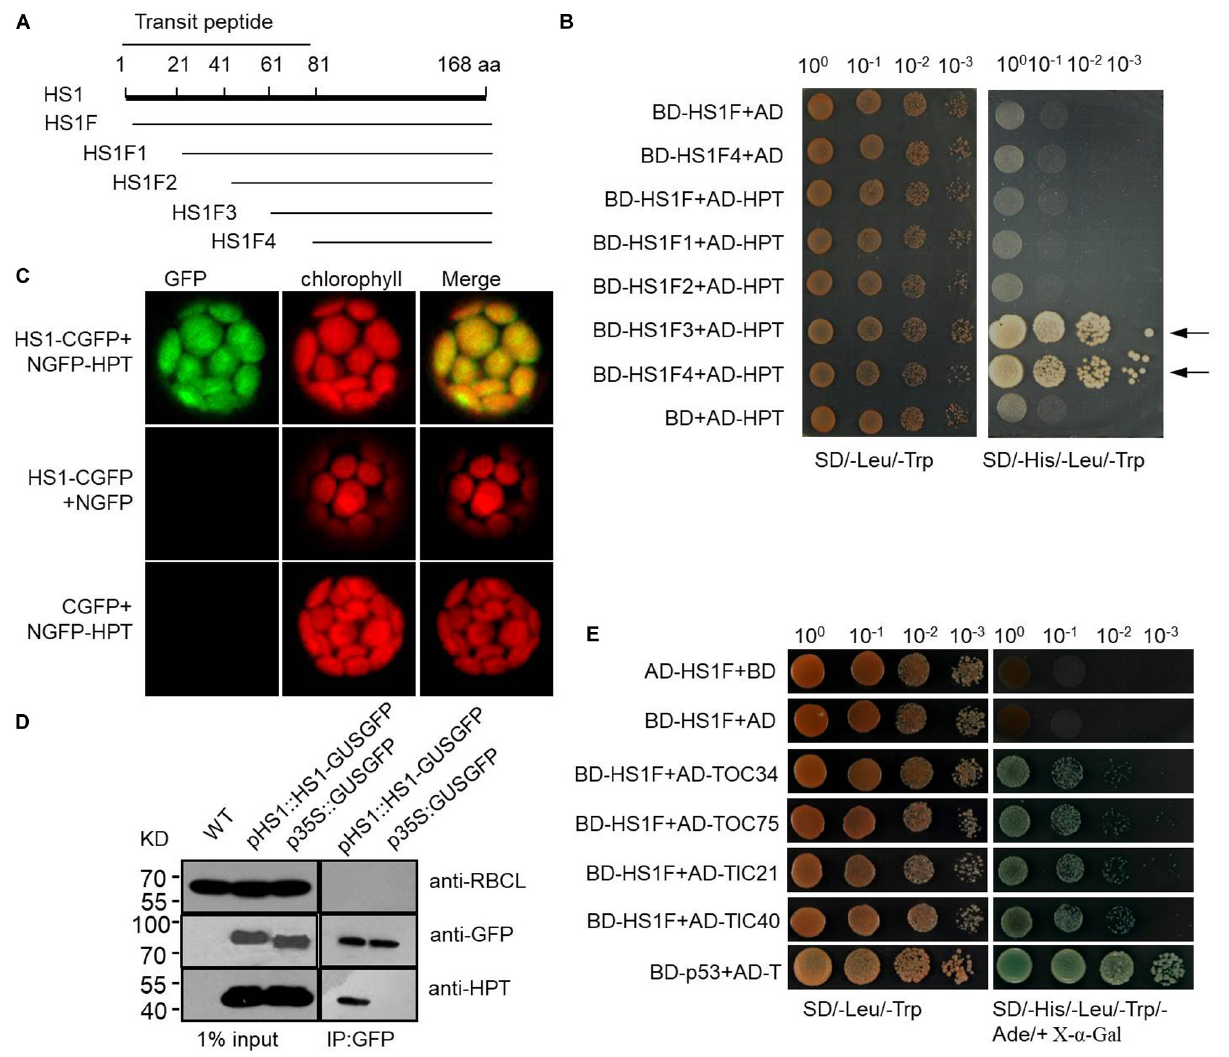
Frontiers in Plant Science |